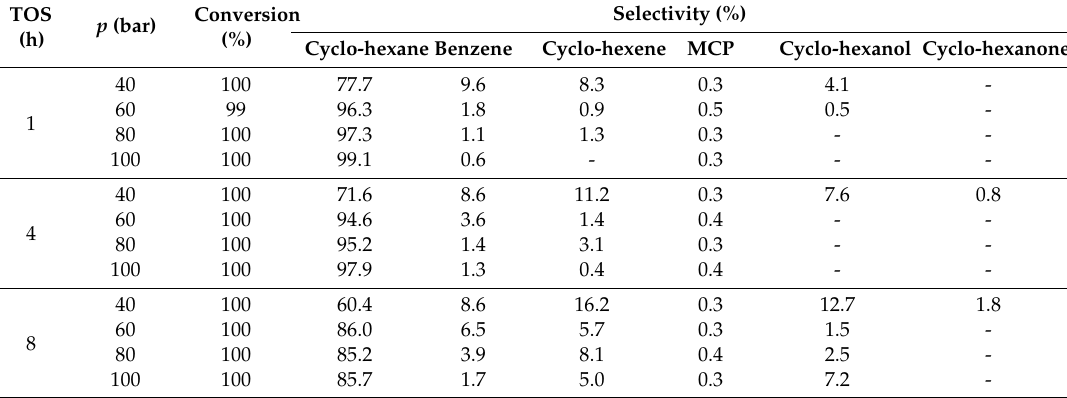
Table 4. Effect of pressure on the performance of 10Ni10Co/HZSM-5 in the continuous reactor. TOS